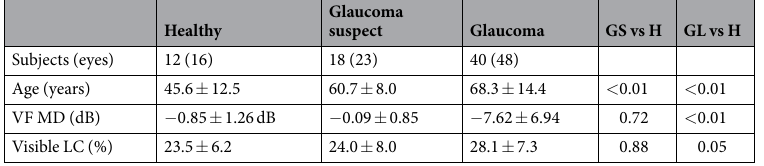
Table 1. Study population characteristics. Number of eyes, age, visual field mean deviation (VF MD) and percentage of visible lamina cribrosa (LC) seen on OCT were listed for the different diagnostic categories